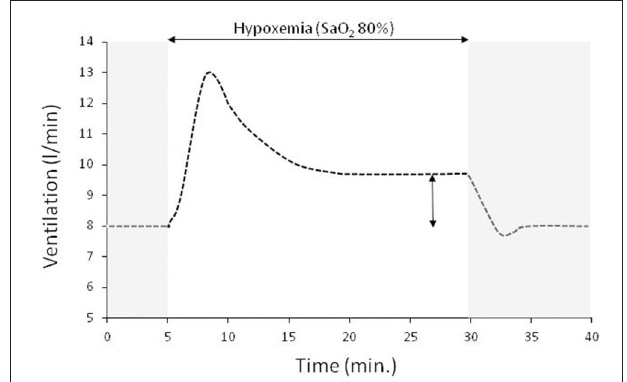
FIGURE 1 | A typical ventilatory response to sustained isocapnic hypoxemia (horizontal double edge arrow) preceded and followed by room air breathing (gray area, SaO 2 97%). In this experiment the drop of SaO 2 to 80% is achieved within 2min and remained at this level for 25min. Sustained isocapnic hypoxemia results in an initial brisk increase in ventilation which then declines to a plateau that is ∼ 20% higher than that at room air breathing (vertical double edge